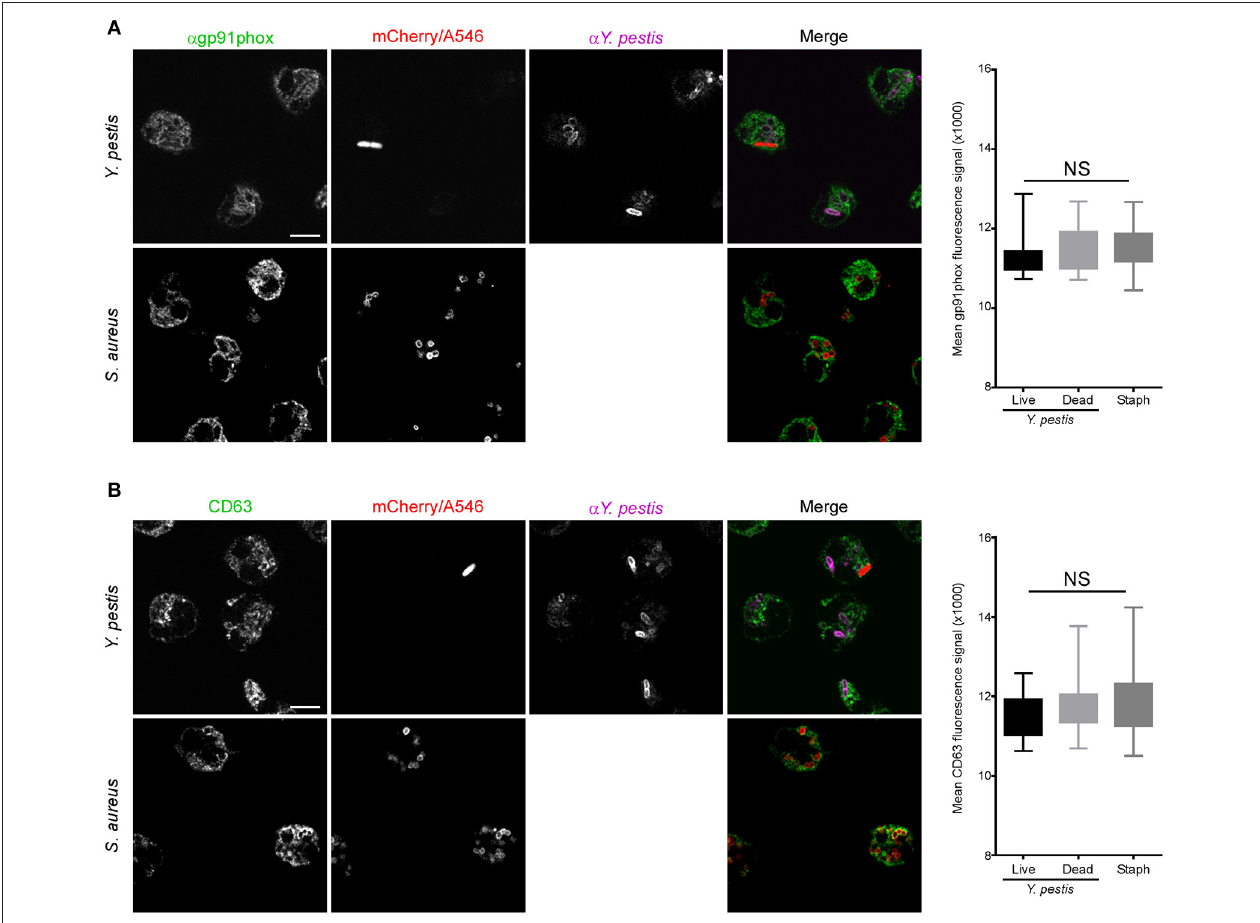
FIGURE 5 | Neutrophil phagosomes containing live or dead Y. pestis associate with gp91phox component of NADPH oxidase and CD63. Neutrophils were infected with Y. pestis KIM6 + pTac-mCherry or Alexa546-labeled S. aureus on fibronectin-coated glass coverslips. At 15min post-infection gentamicin was added to the medium to kill remaining extracellular bacteria. At 30min post-infection the medium was removed and replaced with fresh medium without gentamicin, but with 300 µ M IPTG. Cells were cultured for an additional 90min to induce mCherry expression in remaining live Y. pestis . Coverslips were fixed, stained for IFA with antibodies against Y. pestis and (A) gp91phox, or (B) CD63, and imaged by confocal microscopy. Live Y. pestis were identified by bright mCherry signal. Anti- Y. pestis staining was used to identify dead Y. pestis . We did not distinguish between live or dead S. aureus . Images are representative of 10 separate micrographs for each condition. Scale bar represents 5 µ m. The box and whisker plots to the right of each set of panel show combined data for fluorescence intensity surrounding live Y. pestis , dead Y. pestis , or S. aureus phagosomes. Differences in fluorescence intensities were determined by one-way ANOVA followed by Holm-Sidak’s multiple comparisons test. The box represents 25–75th percentile, the whiskers represent minimum and maximum values. No statistical difference was found between any of the conditions